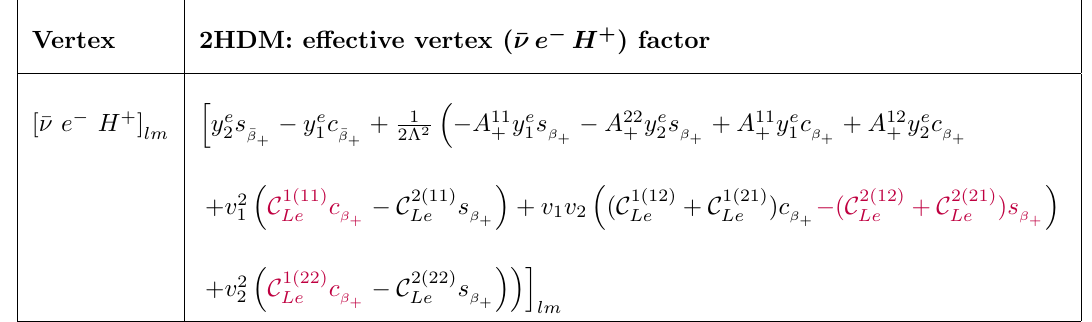
Table 35. 2HDM: coupling of Singly charged scalar with a charged lepton and a neutrino. Here, s (cid:18) = sin (cid:18) i , c (cid:18) = cos (cid:18) i and l; m are the fermion family i i